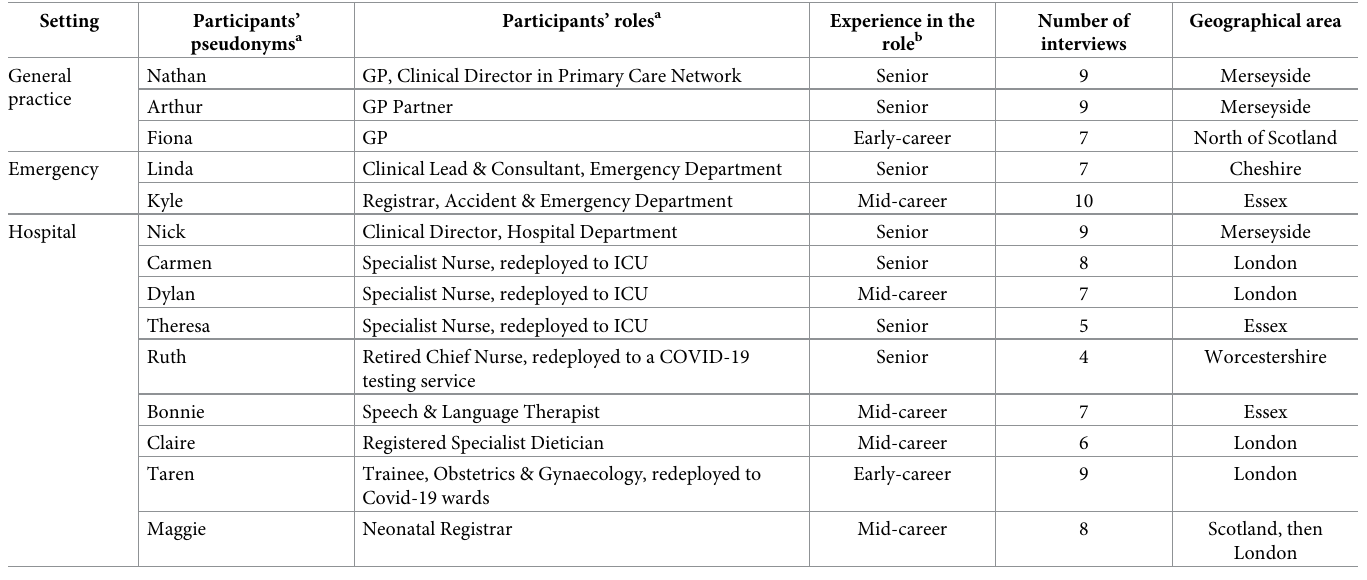
Table 1. Participant